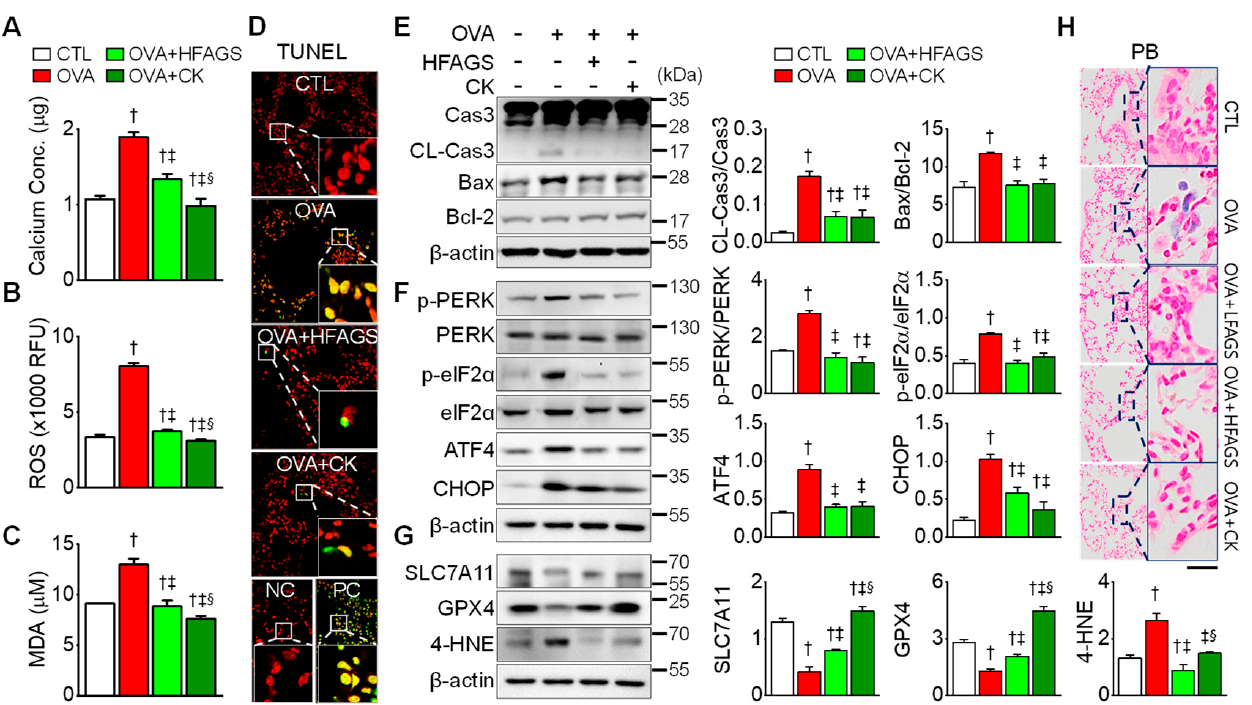
Figure 5. Inhibitory effects of FAGS and CK on apoptotic, ER stress, and ferroptotic signals in lung tissue obtained from OVA-exposed mice. ( A ) Calcium concentration. ( B ) ROS level. RFU represents relative fluorescence units. ( C ) MDA level. ( D ) TUNEL-positive cells. Counterstaining was performed via incubation with 5 µ g/mL propidium iodide (red). Scale bar, 50 µ m. NC and PC represent negative control and positive control, respectively. NC, control treated with label solution without terminal transferase; PC, control treated with DNase I. ( E ) Apoptotic signals (cleavage of caspase 3 and increase in Bax/Bcl-2 ratio). Cas3 and CL-Cas3 represent caspase 3 and cleaved caspase 3, re- spectively. ( F ) ER stress markers. ( G ) Ferroptotic markers. ( H ) Perls Prussian blue staining showing iron accumulation. Data are shown as mean ± SE (each group, n = 5). † p < 0.05 compared with CTL. ‡ p < 0.05 compared with OVA. § p < 0.05 compared with HFAGS.